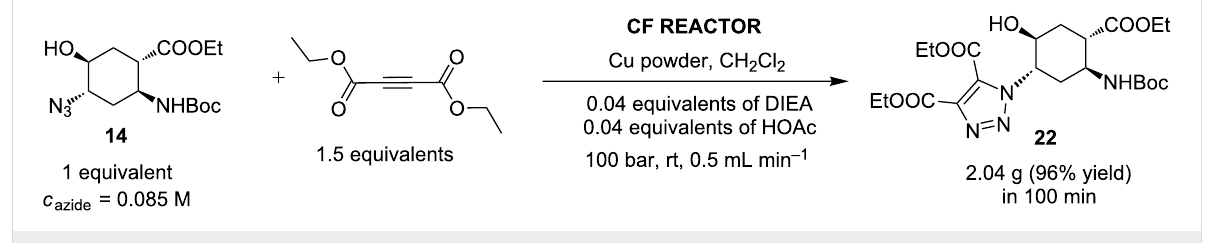
Scheme 2: Gramm-scale CF synthesis of triazole 22 under conditions B .